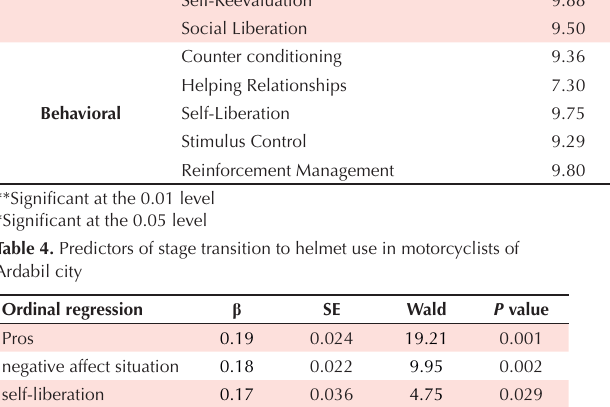
Table 3. One-way ANOVA to compare "processes of change" scores across stages of change Process of change Mean SD P value Consciousness Raising Cognitive